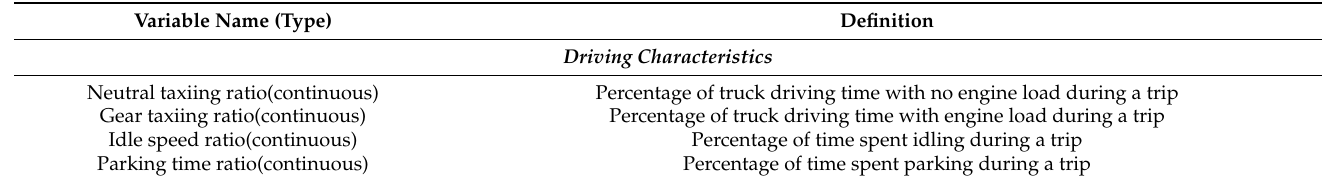
Table 4. The summary of HDDTs’ naturalistic driving